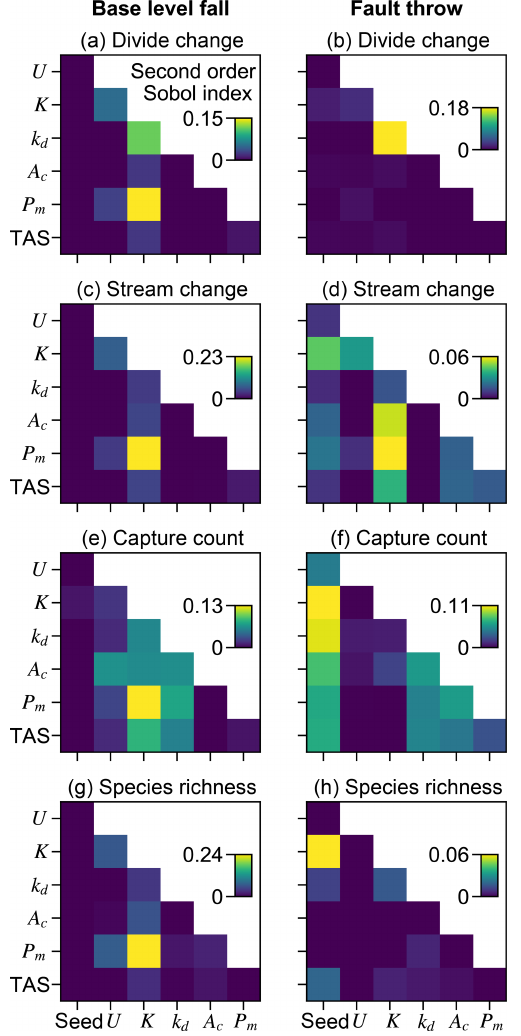
Figure 9. Second-order Sobol indices. Second-order indices of paired model factors for the perturb-phase responses. A relatively large value in a subplot indicates that the interaction of the factor pair affects the response more than other factor pairs with lower index values.